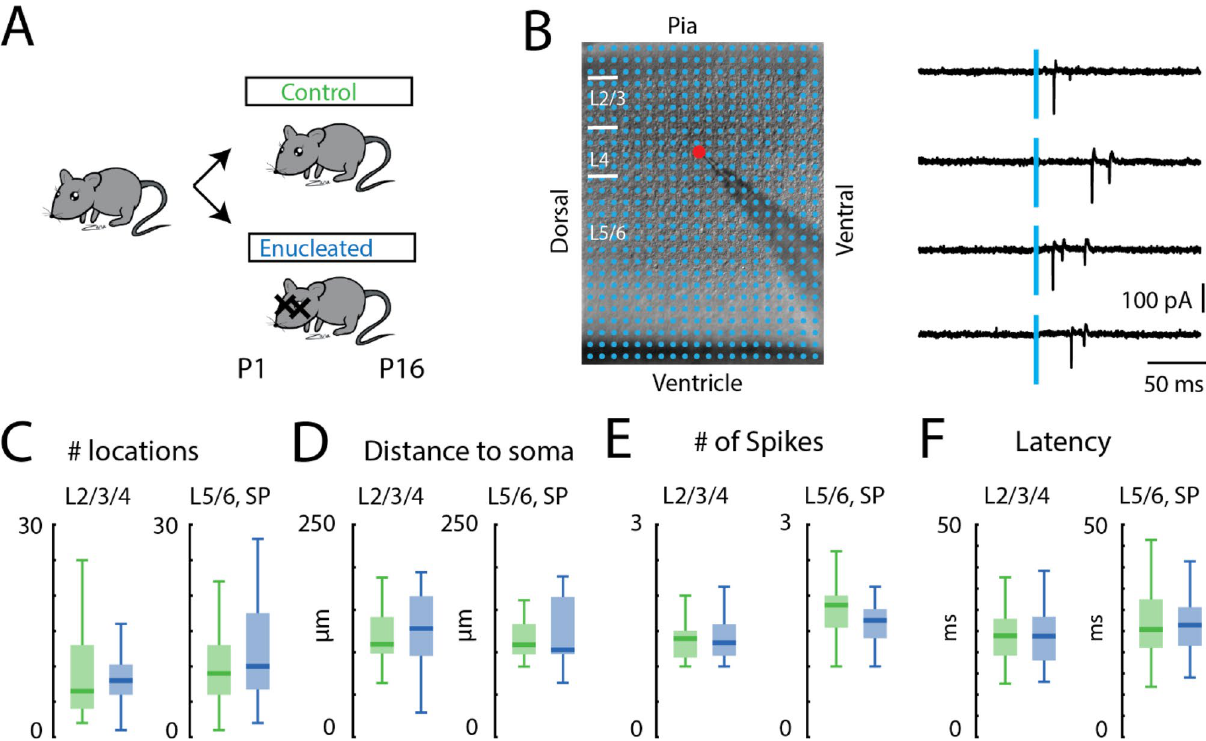
Figure 1. Spiking responses to glutamate photostimulation are not changed in enucleated animals. ( A ) Binocular enucleation is performed at P1/P2 and the glutamatergic connections received by GABAergic interneurons are studied at P16/P17. ( B ) An example LSPS experiment in a coronal slice of V1. LSPS stimulation locations are marked as blue dots on the DIC image. The red dot indicates soma location of the recorded Gad2 interneuron. White bars mark layer boundaries. The length of the white bars is 100 μm. Example traces of action potentials in response to glutamate photostimulation through cell-attached recording. Blue line indicates uncaging time point. ( C ) Boxplot of the number of locations where action potentials can be evoked by glutamate photostimulation of the cortical excitatory neurons. P > 0.05. ( D ) Boxplot of the distance within which 80% of action potentials were evoked in cortical excitatory neurons. P > 0.05. ( E ) Boxplot of the average number of action potentials evoked by glutamate photostimulation of the cortical excitatory neurons. P > 0.05. ( F )